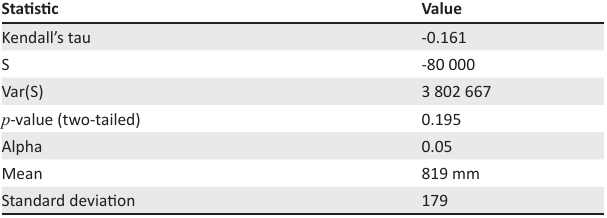
TABLE 4: Mann–Kendall trend test and two-tailed test (annual precipitation). Statistic